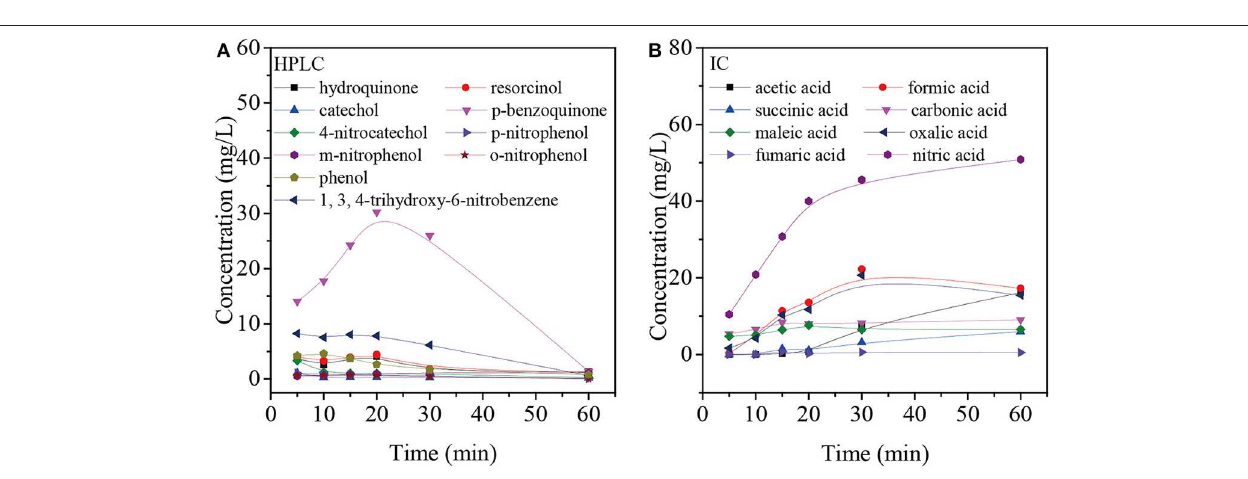
to CO 2 and H 2 O. In addition, the accumulation of nitrate indicates that the COP has been accompanied by the reaction of denitration ( Figure 9